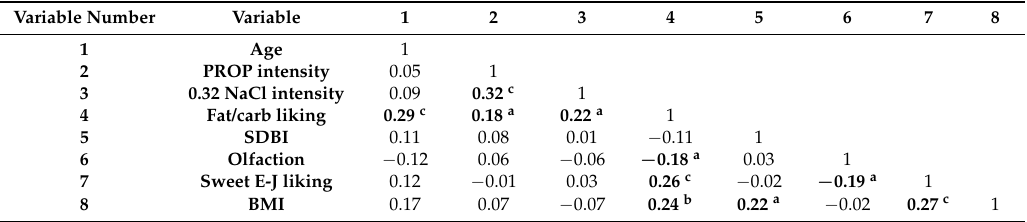
Table 1. Bivariate correlations among variables used in structural equation models in chronic smokers ( n = 135) 1